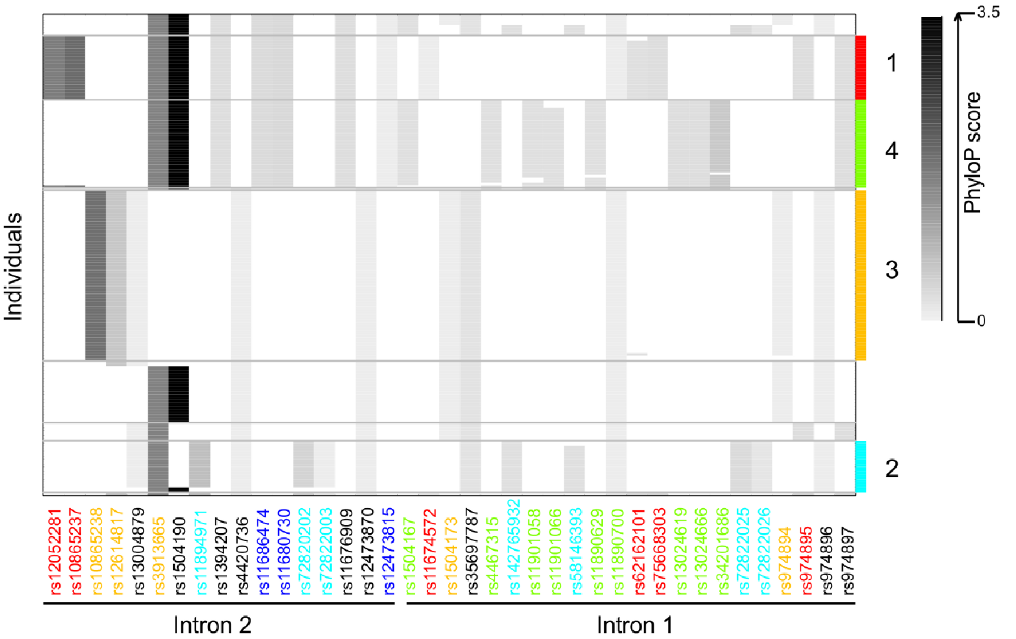
Figure 3. Haplotype structure of common SNPs within the fine-mapped interval. Each row corresponds to a phased chromosome from 93 Finnish individuals in the 1000 Genomes Project. Each column represents one of the 39 SNPs that are segregating in the sequenced regions and also in the fine-mapped interval spanning intron 1 and 2. Derived alleles at conserved sites are shown in gray scale with black being the most highly conserved sites by PhyloP and white showing the ancestral allele. The four major haplotypes are numbered and color coded on the right such that SNPs carried exclusively by one of the four haplotypes have the same label color on the bottom. The three tag SNPs evaluated in [16] are labeled in dark blue.